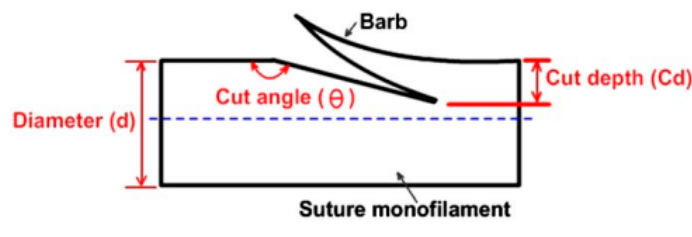
Figure 9. Geometry of a single barb [24].